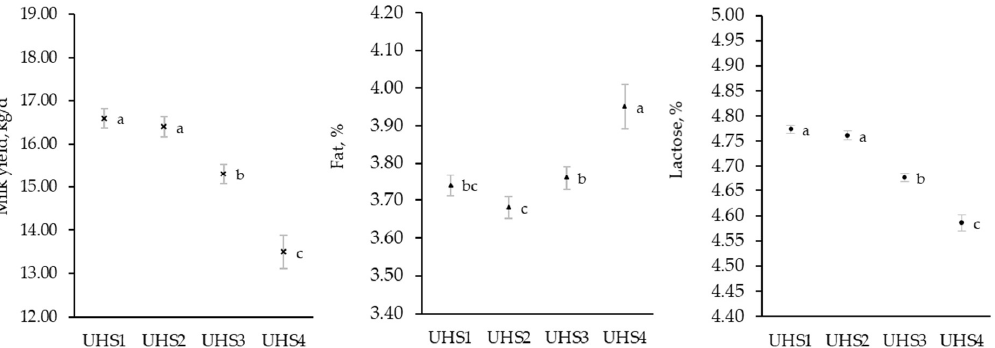
Figure 5. Least squares means of milk yield, fat, and lactose content in different udder health status groups: Milk test-day records were classified according to somatic cell count (SCC) and differential somatic cell count (DSCC) as follows: UHS1 if SCC ≤ 200,000 cell/mL and DSCC ≤ 65%, UHS2 if SCC ≤ 200,000 cell/mL and DSCC > 65%, UHS3 if SCC > 200,000 cell/mL and DSCC > 65%, and UHS4 if SCC > 200,000 cell/mL and DSCC ≤ 65%. Values with different superscripts within row are significantly different ( p ≤ 0.05).